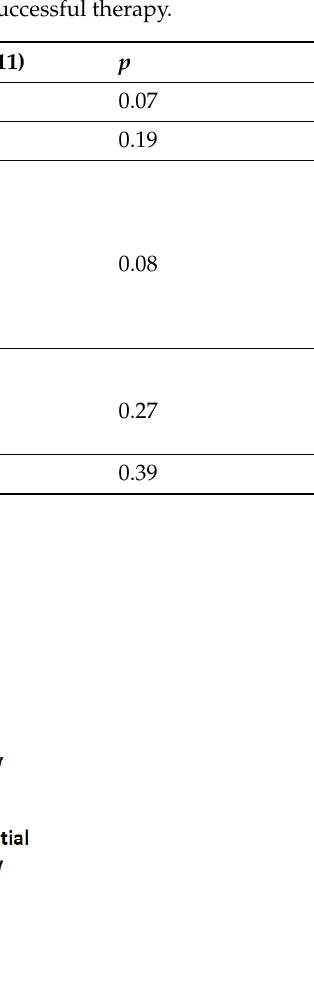
Table 2 . Comparison between patients who failed BQT versus successful therapy. Table 2. Comparison between patients who failed BQT versus successful therapy.